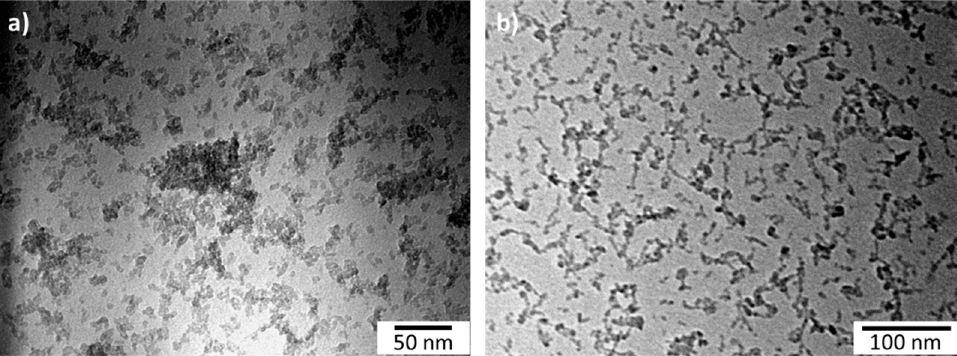
Figure 3. Transmission electron microscopy (TEM) pictures of ( a ) pure TiO 2 and ( b ) TiO 2 /Fe0.5.